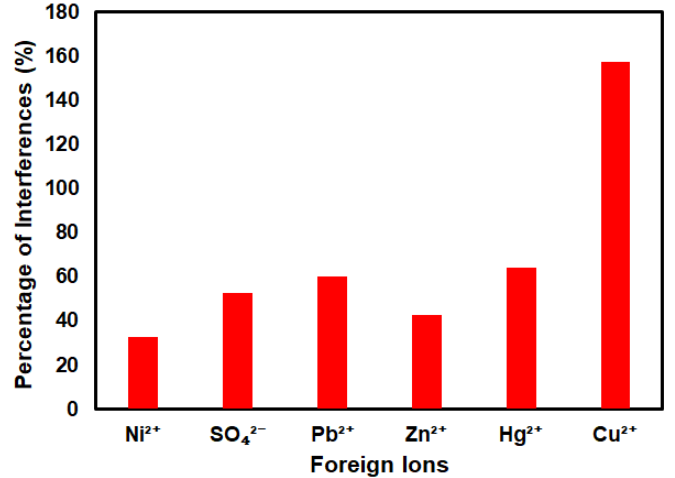
Figure 8. Interference study of the SiNPs / SPCE in the presence of various competitive foreign ions.